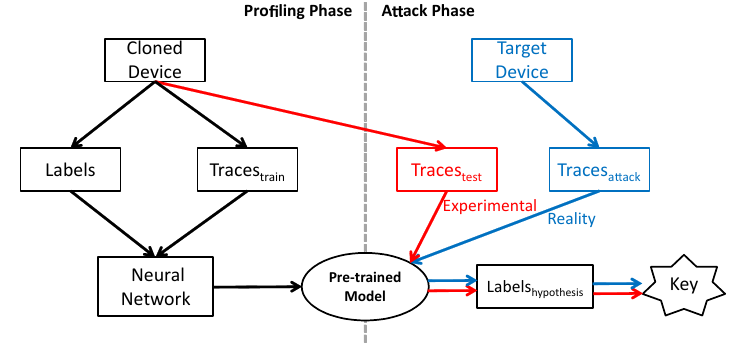
Figure 1: Framework of DL-based profiled